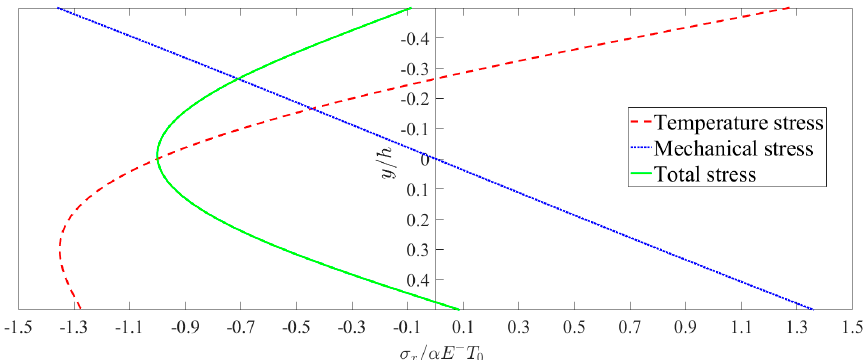
+ Figure 5. Stress composition when E and = . Figure 5. Stress composition when E E and = . Figure 5. Stress composition when E + = E − and α E − T 0 / q = 20. Figure 5. Stress composition when E .